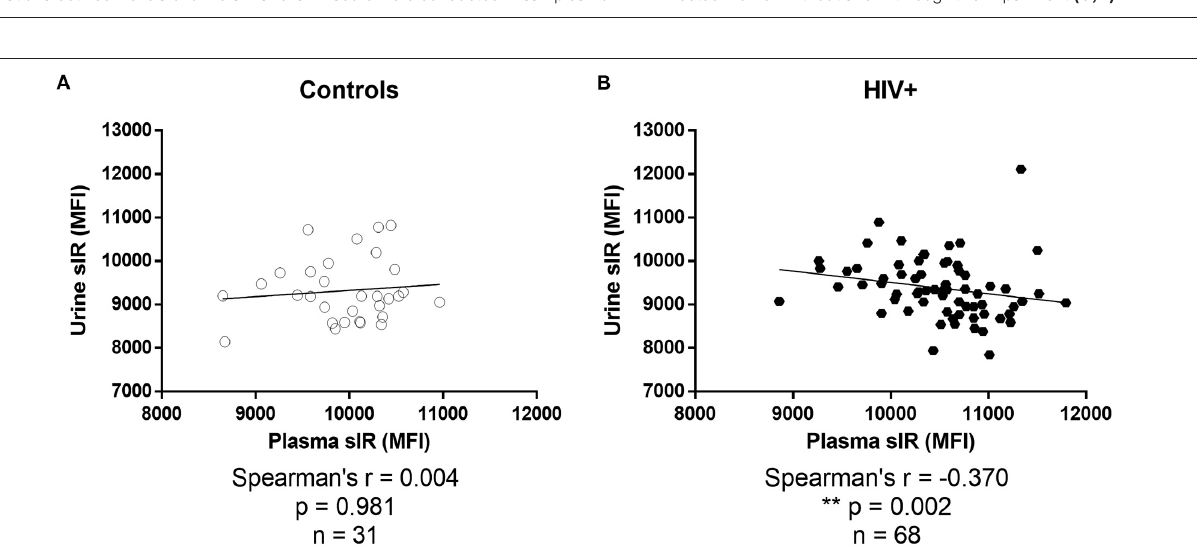
FIGURE 5 | ( n = 13) and HIV-infected women ( n = 71) grouped (C) and stratified by cognitive function (D) . Flow cytometry results were graphed as mean fluorescence intensity (MFI). Graphs show mean and standard deviation [Controls (9,316 ± 719.8), N (9,230 ± 703.8), ANI (9,876 ± 1131), and SI (9,465 ± 412.2).